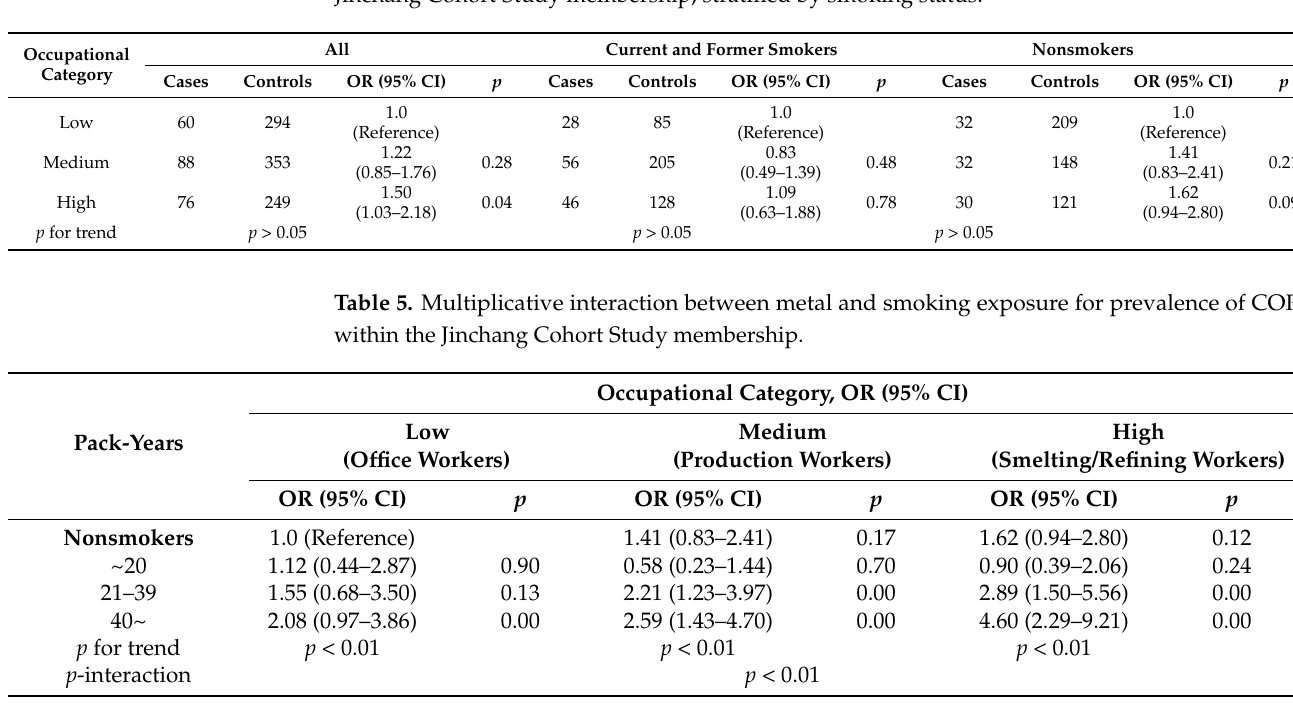
Table 4. Adjusted ORs and 95% CIs between heavy metals and prevalence of COPD within the Jinchang Cohort Study membership, stratified by smoking status.